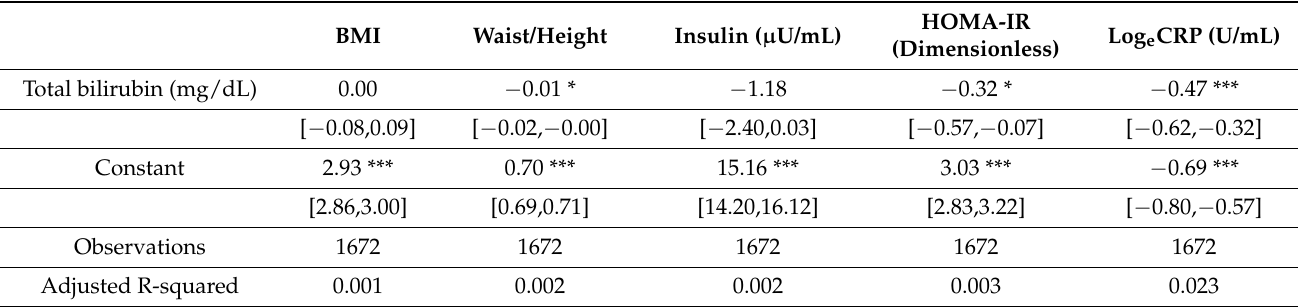
Table 3. Univariable linear regression models evaluating the association between serum total bilirubin and anthropometric and laboratory measurements. Abbreviations as in Table 1.